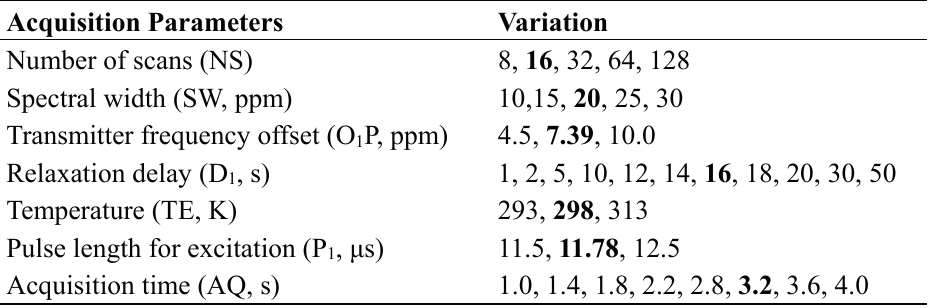
Table 3. Summary of all examined parameters and their variation